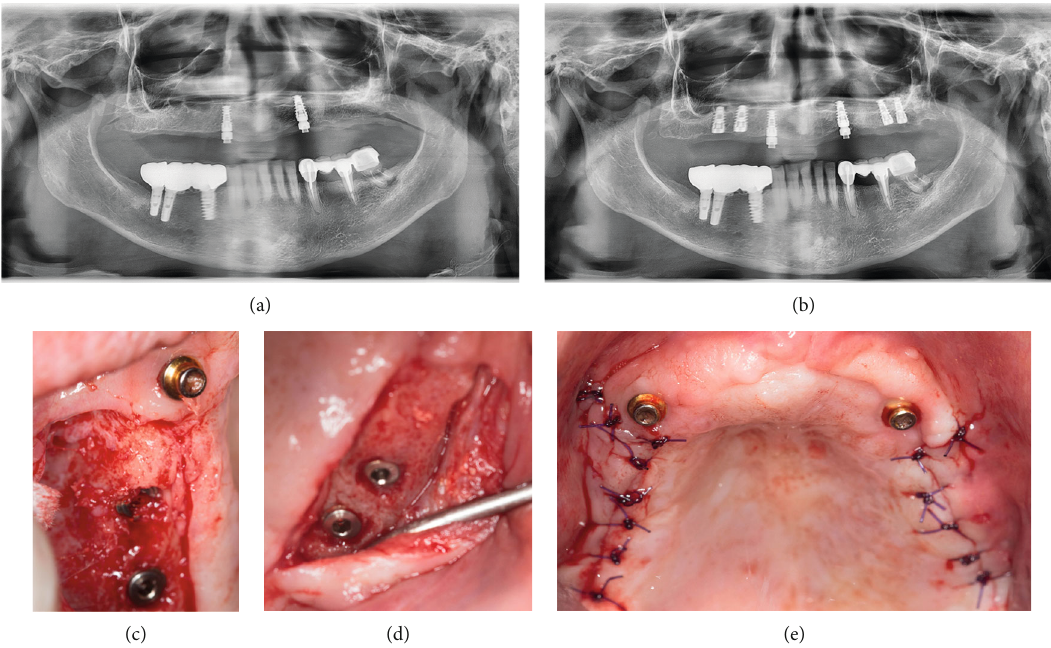
Figure 5: Following sinus graft maturation: (a) Panoramic x-ray 6 months following segmental osteotomy along bilateral sinus augmentation. (b) Panoramic x-ray, 8-months following segmental osteotomy along with bilateral sinus augmentation, and 2 months after implant placement in the sinuses region. (c, d) Two implant placement per each sinus 6-months following bilateral sinus fl oor elevation. (e) Occlusal view of the maxilla immediately after implant placement and fl aps